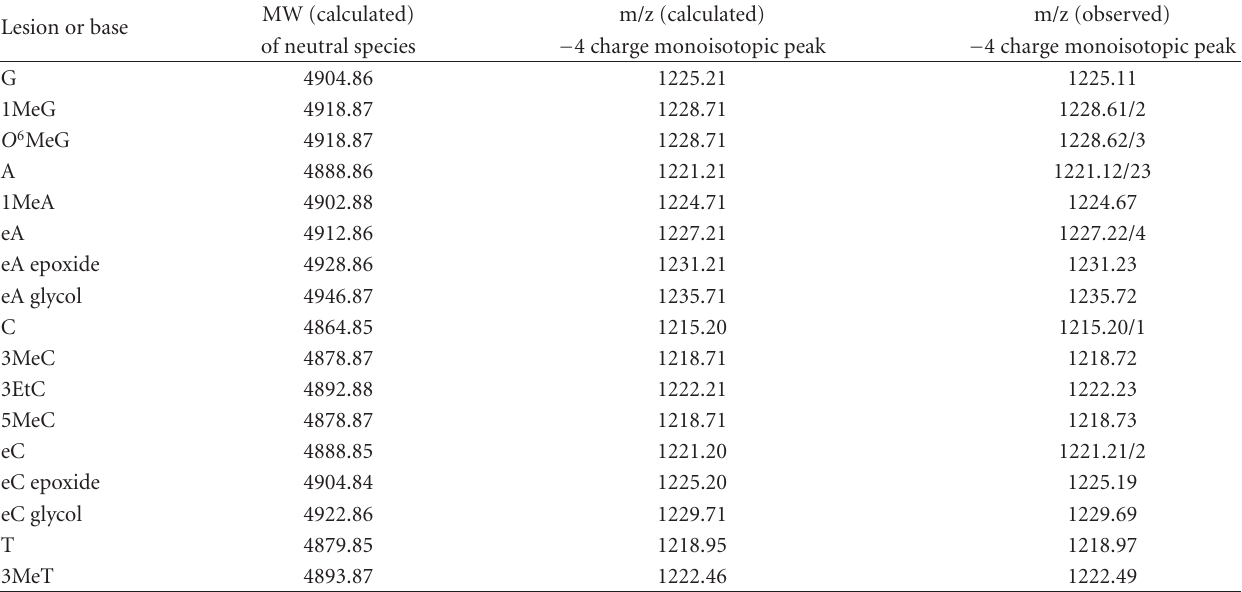
Table 1: Calculated and observed monoisotopic molecular weight of oligonucleotides and intermediates present in the AlkB repair reactions. Lesion or